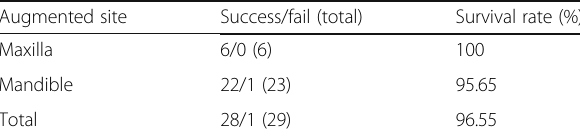
Table 2 Implant survival rate Augmented site